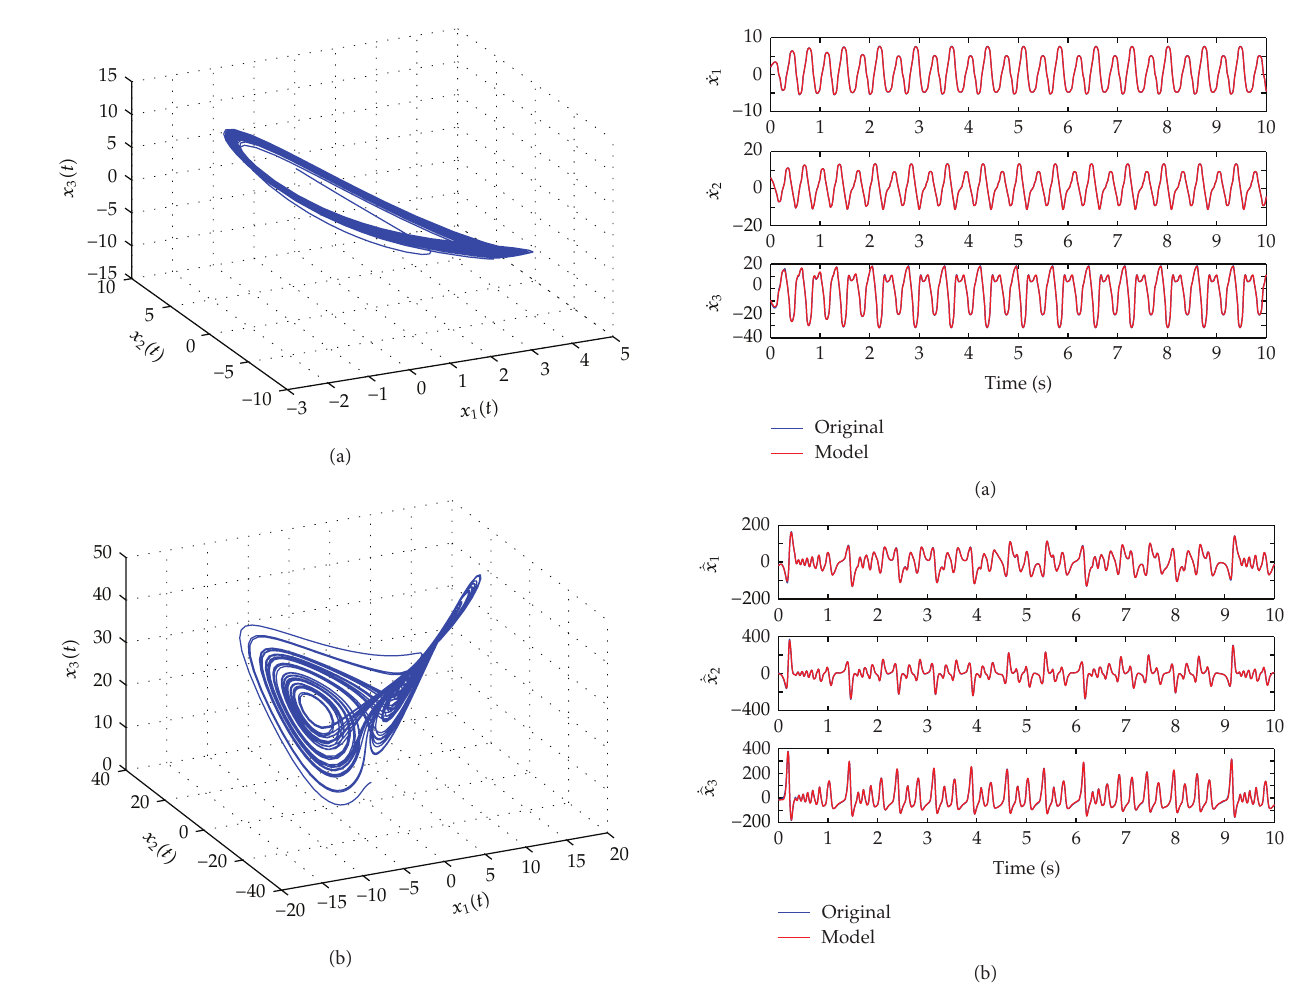
. 𝑋(𝑡) for original system and NN . ̂𝑋(𝑡) for original system and NN model.